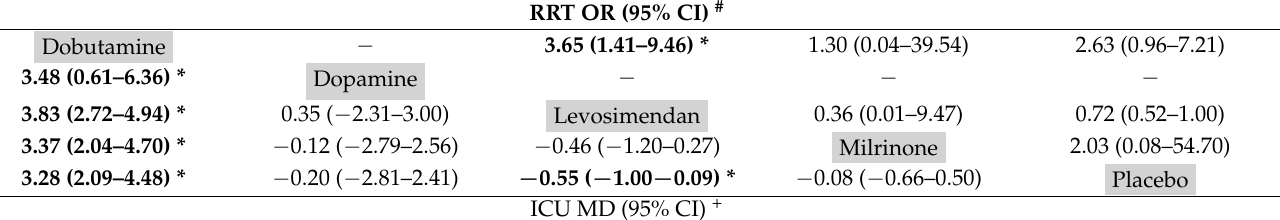
Table 2. Results from the multiple-treatment comparison analyses for renal replacement therapy (RRT) and intensive care unit